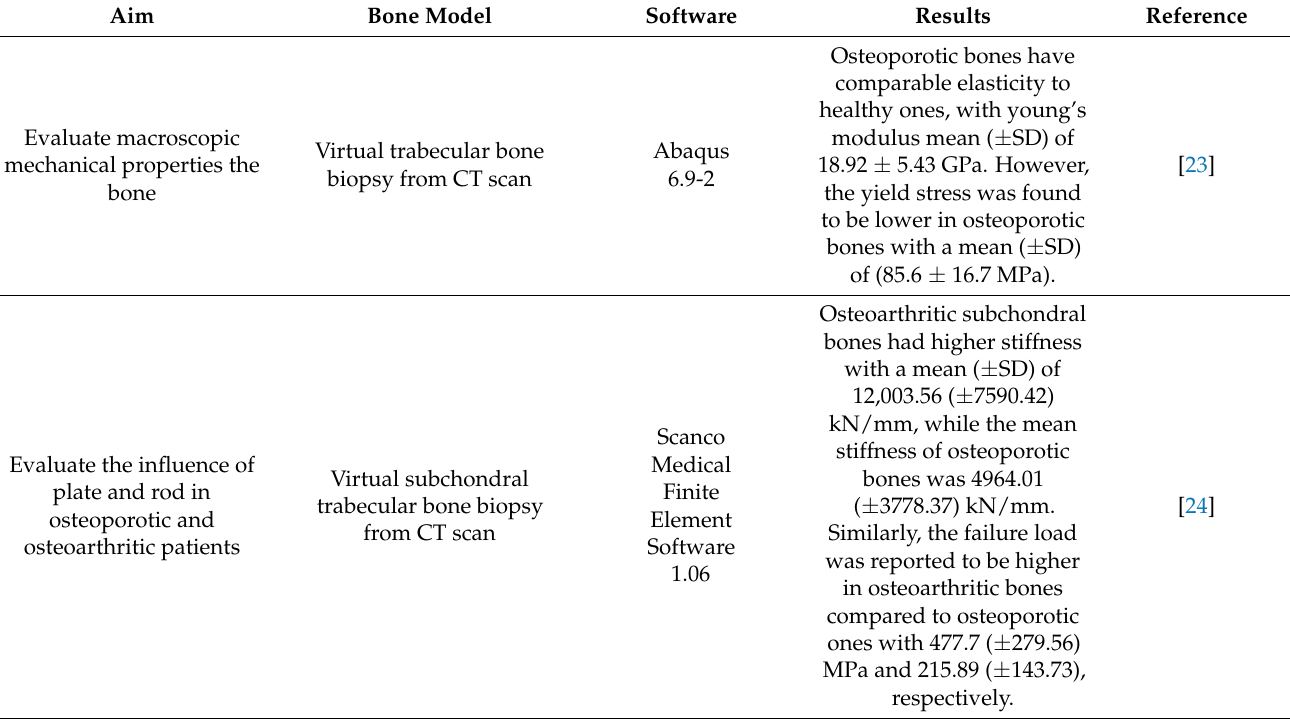
Table 3. FEA for bone microstructure